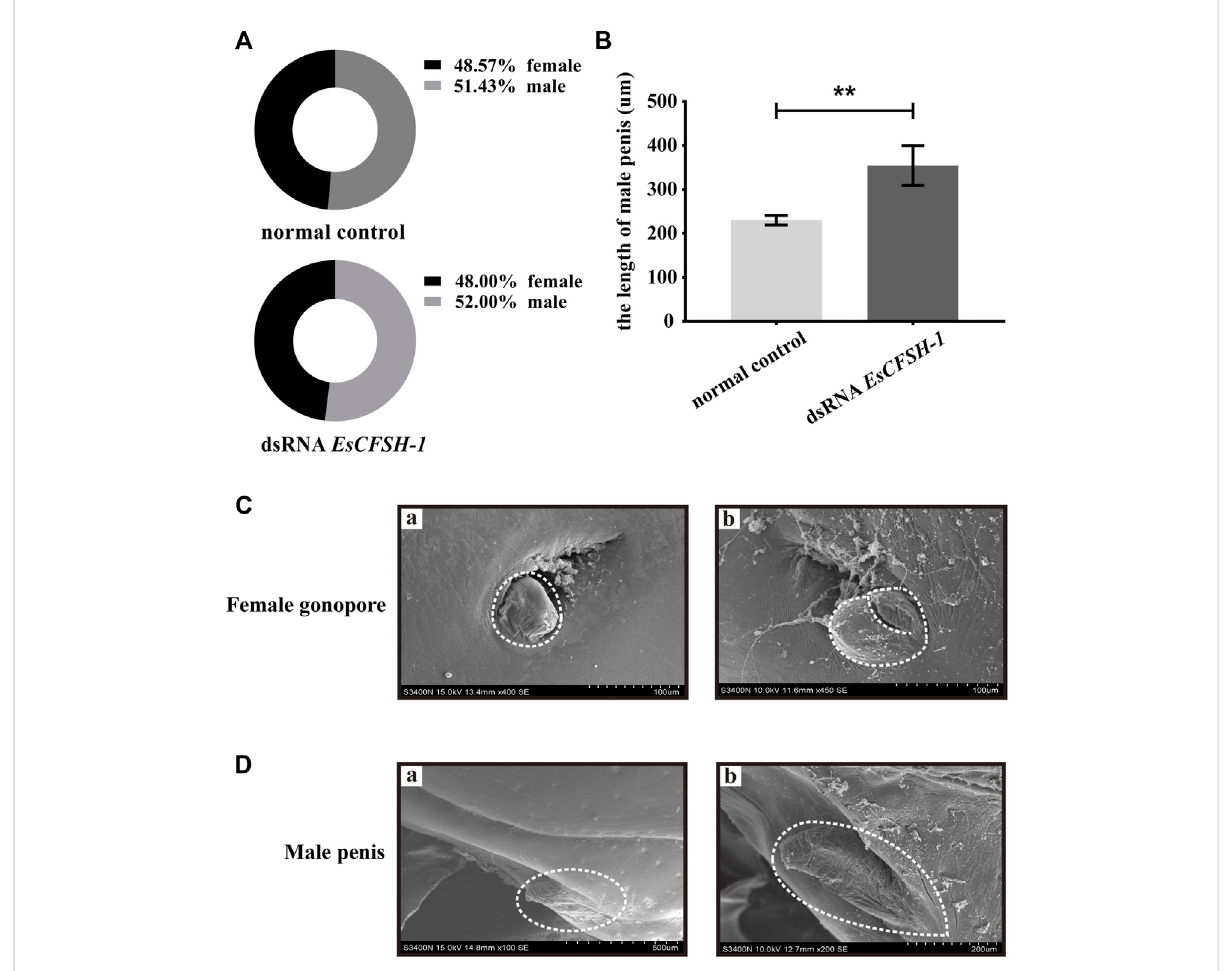
FIGURE 9 The female and male sexual characteristics of juvenile E. sinensis after EsCFSH-1 knockdown (A) Sexual ratio of normal control group and dsRNA EsCFSH-1 group (B) The length of male penis ( μ m). The data were presented as means ± SEM of four separate individuals ( n = 3), and the double-stars indicated p < 0.01 (C) The female gonopore characteristics before (A) and after (B) treated dsRNA EsCFSH-1 (D) The male penis characteristics before (A) and after (B) treated dsRNA EsCFSH-1